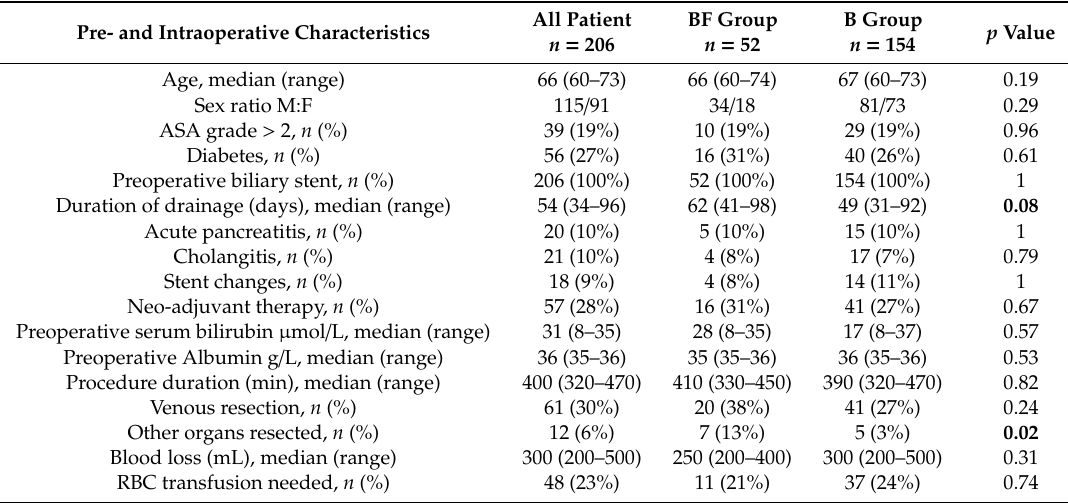
Table 1. Pre- and intraoperative characteristics.